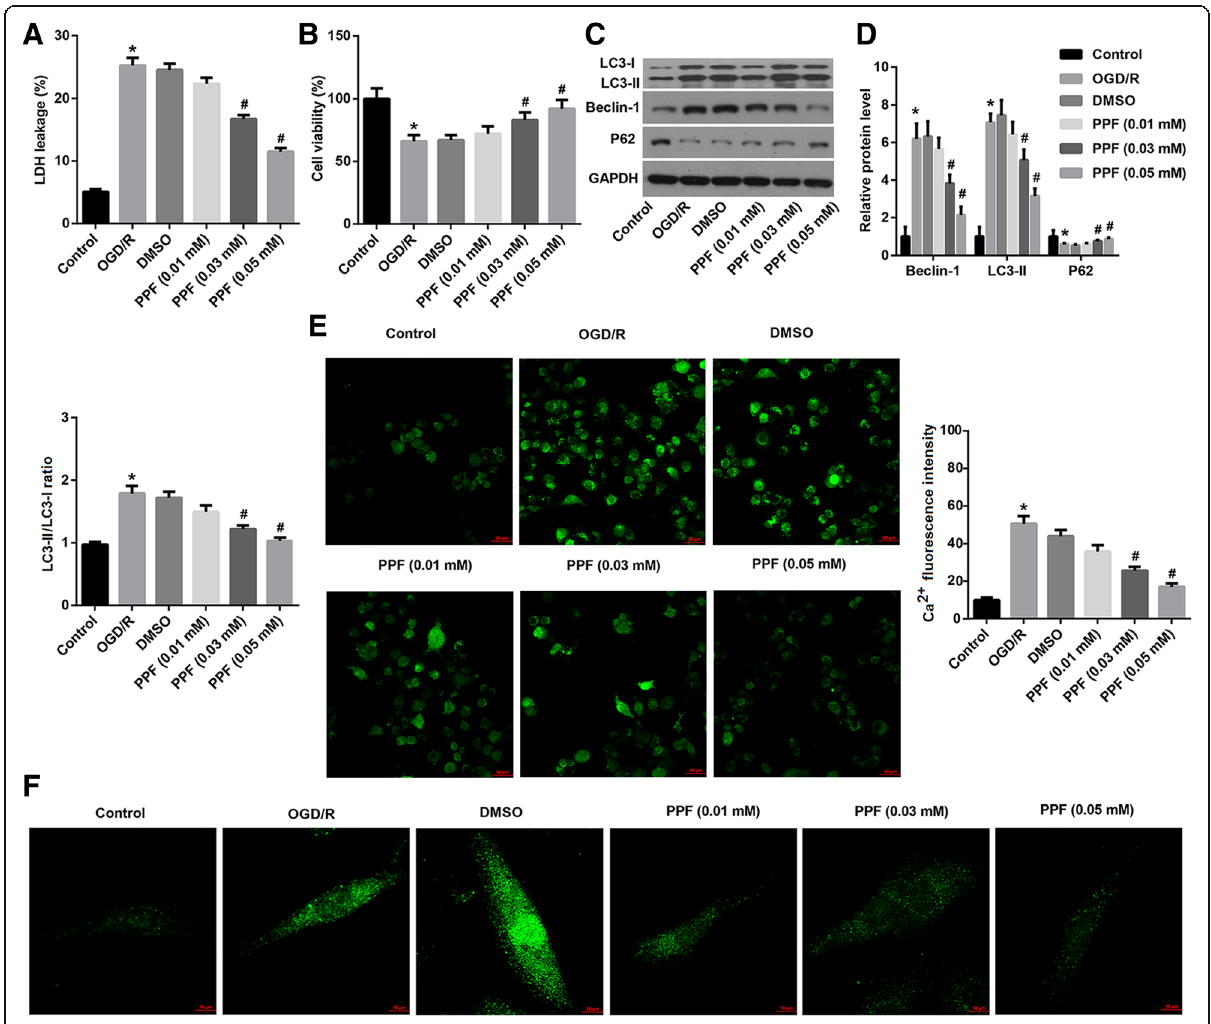
Fig. 2 PPF antagonized OGD/R-triggered cell injury, autophagy induction and [Ca 2+ ]i elevation. Propofol (PPF) with various concentrations (0.01 mM, 0.03 mM, 0.05 mM in 0.1% DMSO) was added into OGD/R-exposed neurons. a LDH release. b Cell viability using MTT assay. c , d Western blot analysis of protein expression of autophagy-related genes LC3, Beclin1, and p62. Quantification of western blots was shown. e Ca 2+ fluorescence images. Scale bar: 50 μ m. The qualification of Ca 2+ - fluorescence intensity was shown. f The autophagosome puncta of GFP-LC3 by immunofluorescence. Scale bar: 10 μ m. Values are represented as the mean ± SD from three independent experiments. * p < 0.05 vs. Control group; # p < 0.05 vs. DMSO